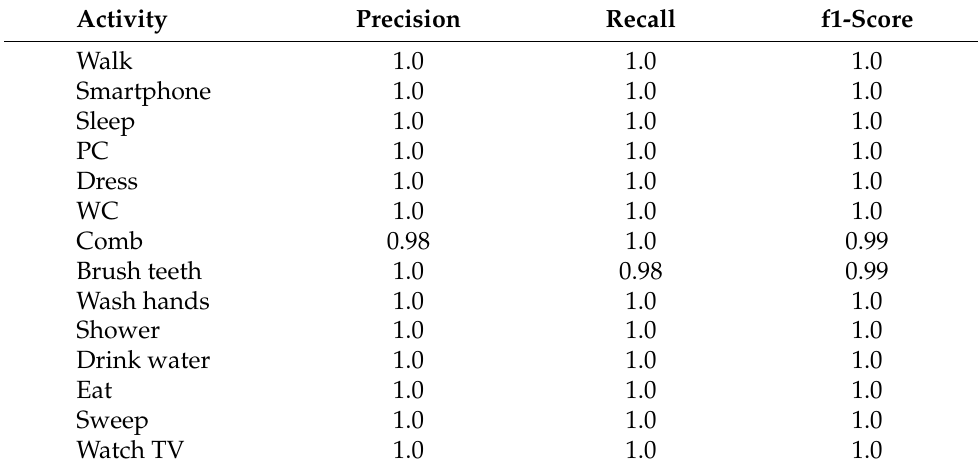
Table 5. Algorithm results in experiment